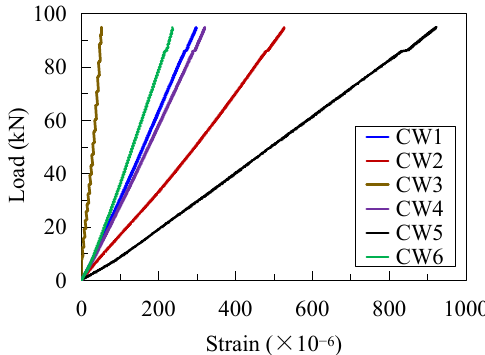
Figure 7. Strain development of the CSW under P max